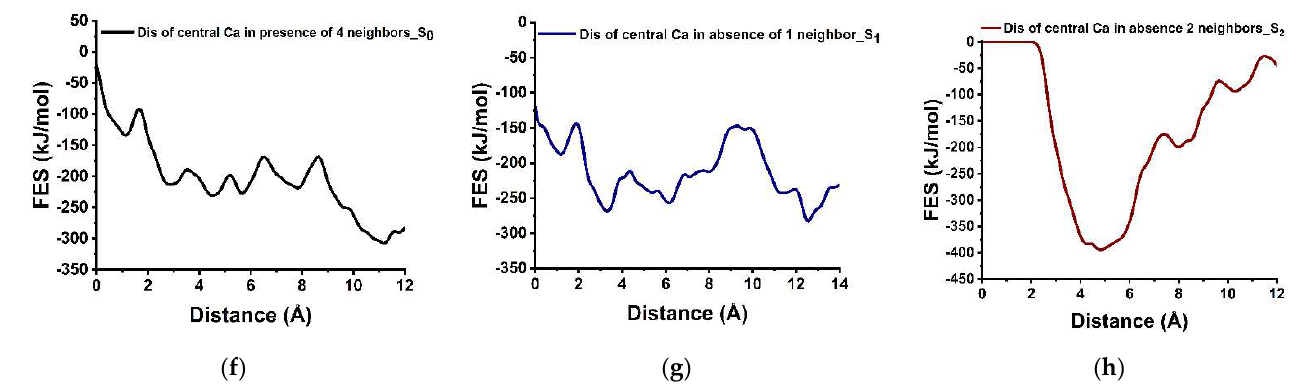
Figure 5. The representative dissolution profile is quantified by free energy surface (FES) of (100) facet of β-C 2 S. Case I: dissolution of central Ca surrounded by four Ca neighbors (red Ca in Figure 1I) in different scenarios: the presence of all four Ca neighbors ( a ) and stepwise absence ( b – e ). Case II: dissolution of central Ca located in Ca row (red Ca in Figure 1II) in the presence of all four Ca neighbors ( f ) and absence of 1,2 Ca neighbors ( g , h ) at 298 K.